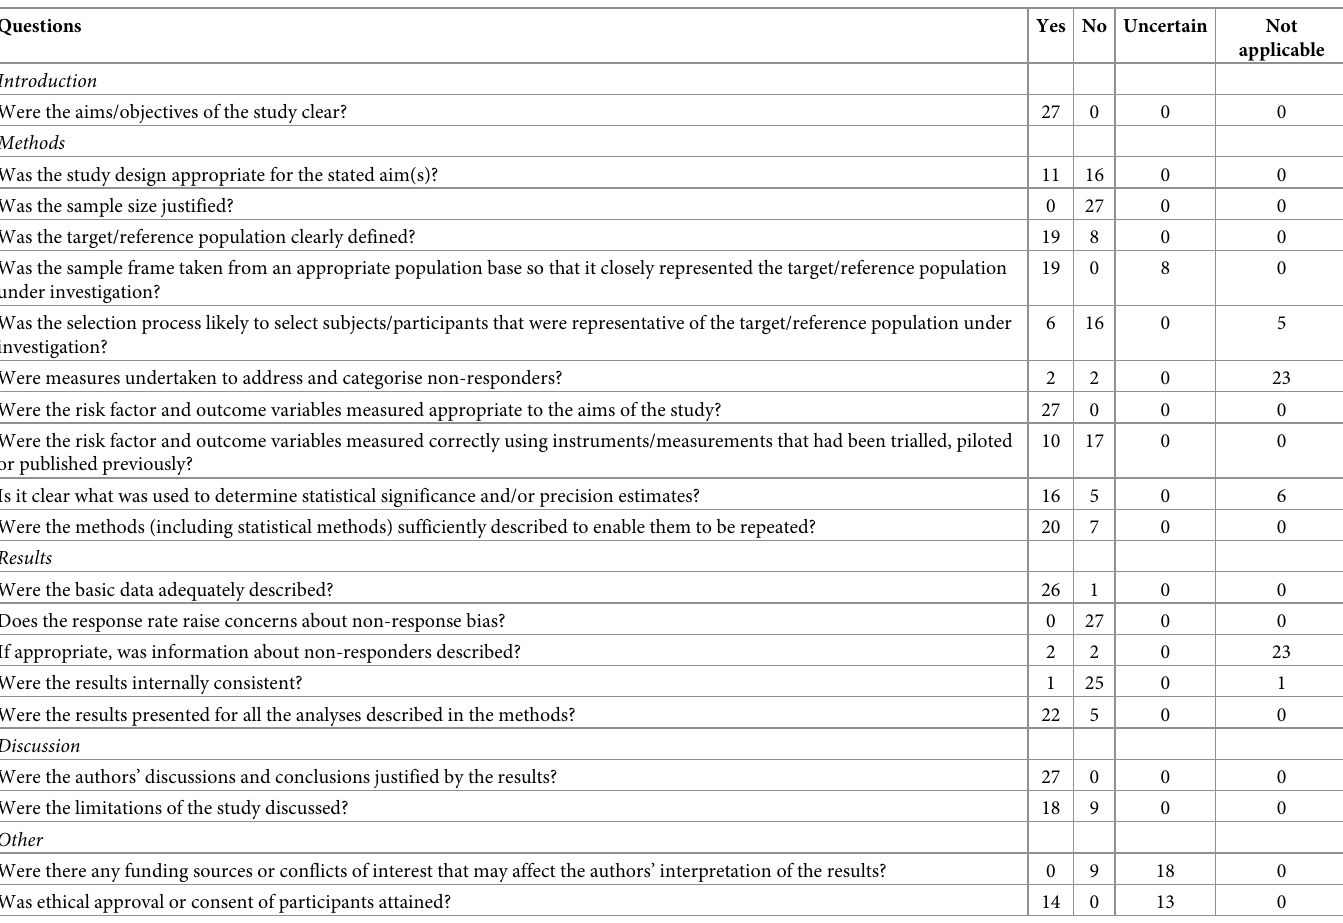
Table 5. Assessment of the studies included in the systematic review according to the appraisal tool for cross-sectional studies (AXIS).